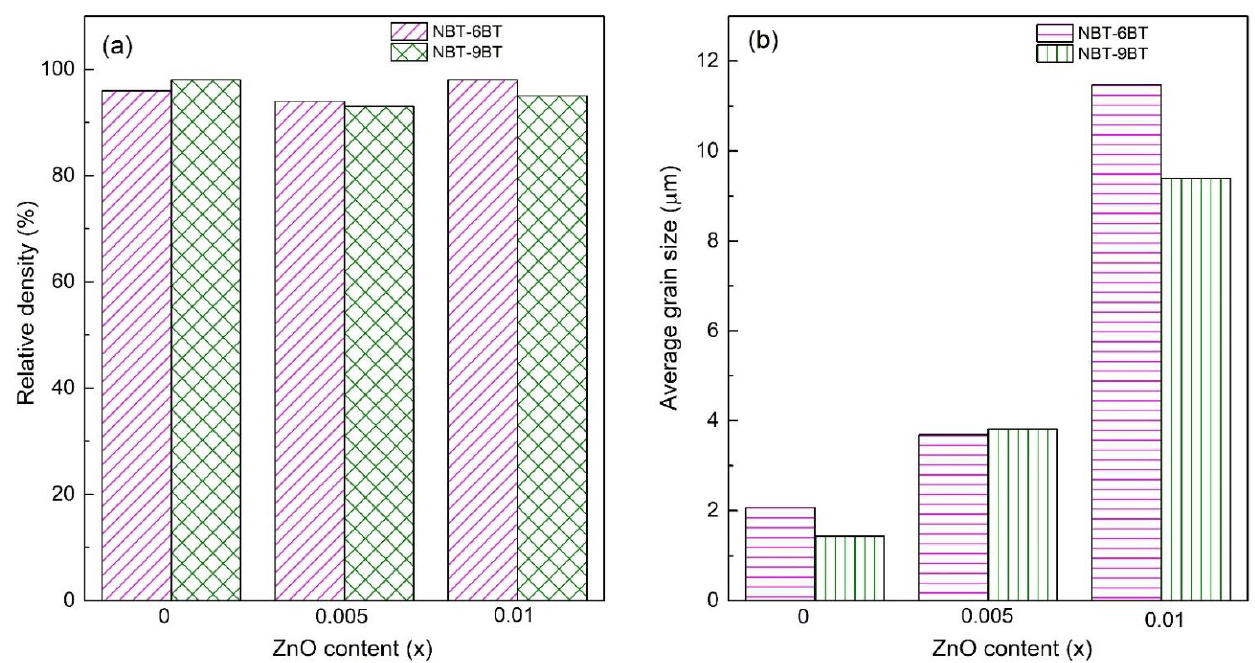
Figure 1. Scanning electron micrographs of thermally etched and polished surface of ( a ) NBT-6BT, ( b ) NBT-6BT-0.005Zn, ( c ) NBT-6BT-0.01Zn, ( d ) NBT-9BT, ( e ) NBT-9BT-0.005Zn and ( f ) NBT-9BT- 0.01Zn. The inset shows the corresponding grain size distribution.